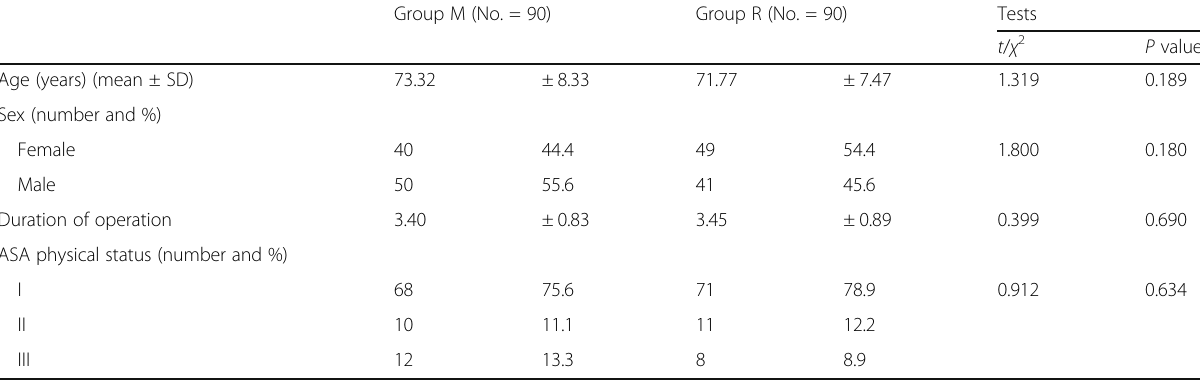
Table 1 Demographic data of the two studied groups